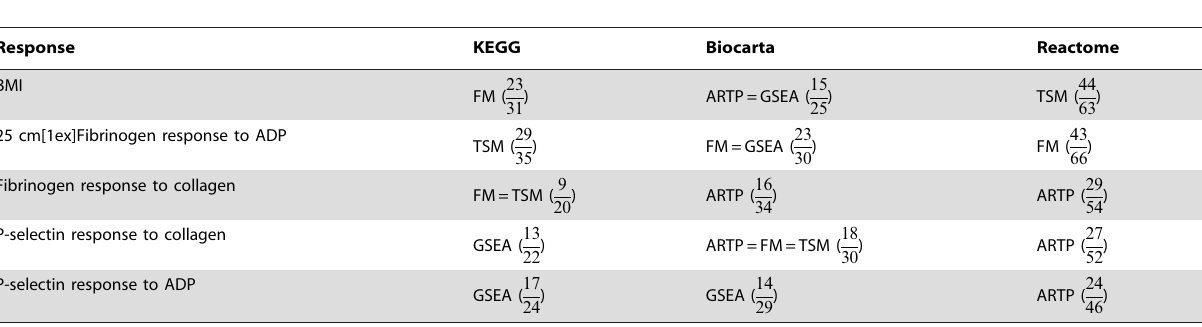
Table 7. Performance of the methods when applied on the data of the